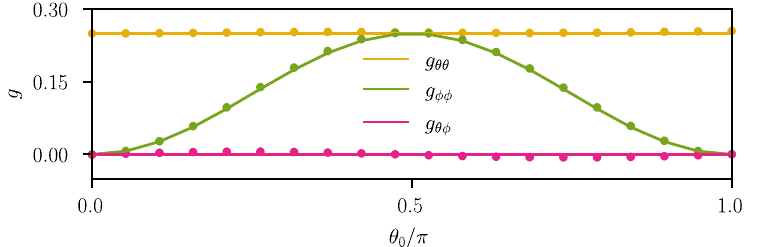
Figure 4. Extraction of the QMT of the continuous variable system. The numerical results of the QMT g θθ (yellow dots), g φφ (green dots), and g θφ (pink dots) are plotted with the theoretical results (solid lines). The whole adiabatic evolution is simulated with Ω = 0.001 K , P = K , δθ = δφ = π T = 100/ Ω